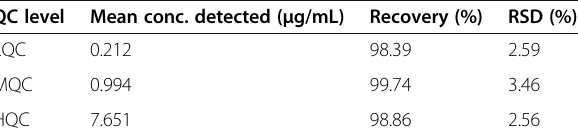
Table 2 Recovery data for LTZ in rat plasma